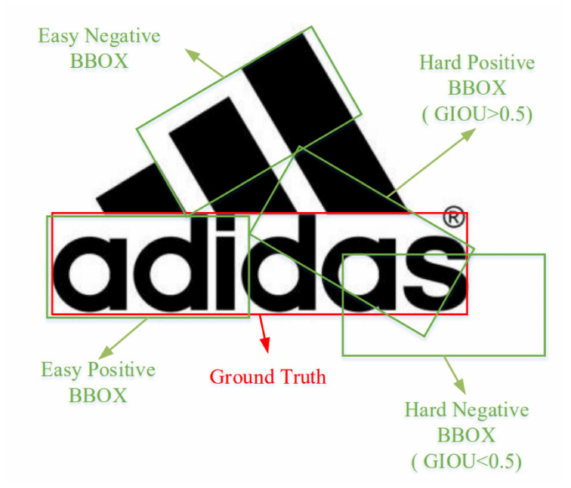
Figure 12. Schematic of four